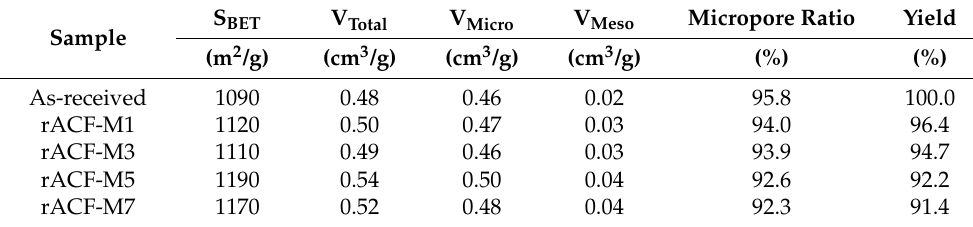
Table 2. Textural Properties of Activated Carbon Fibers according to the Microwave Heating